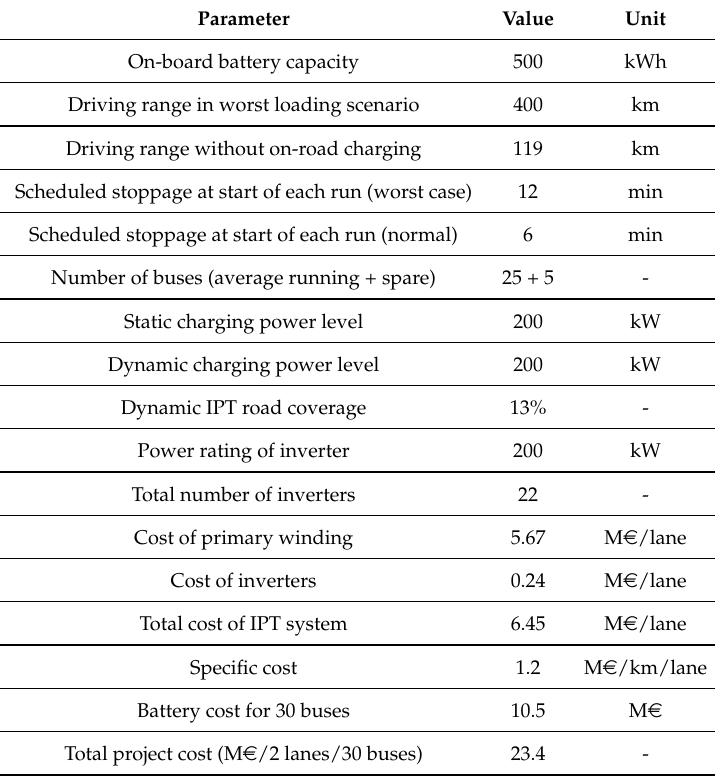
Table 3. IPT system